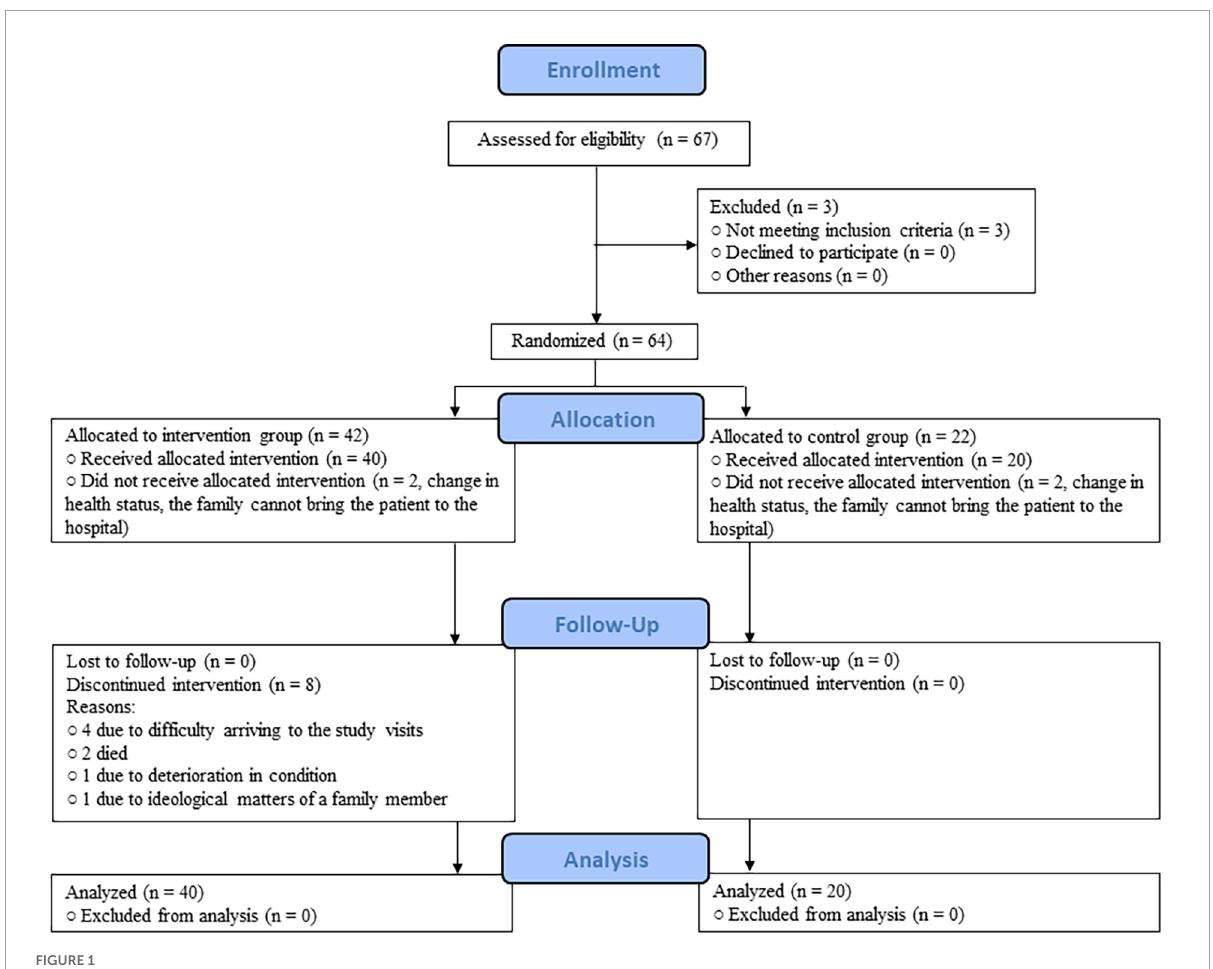
FIGURE1 CONSORT